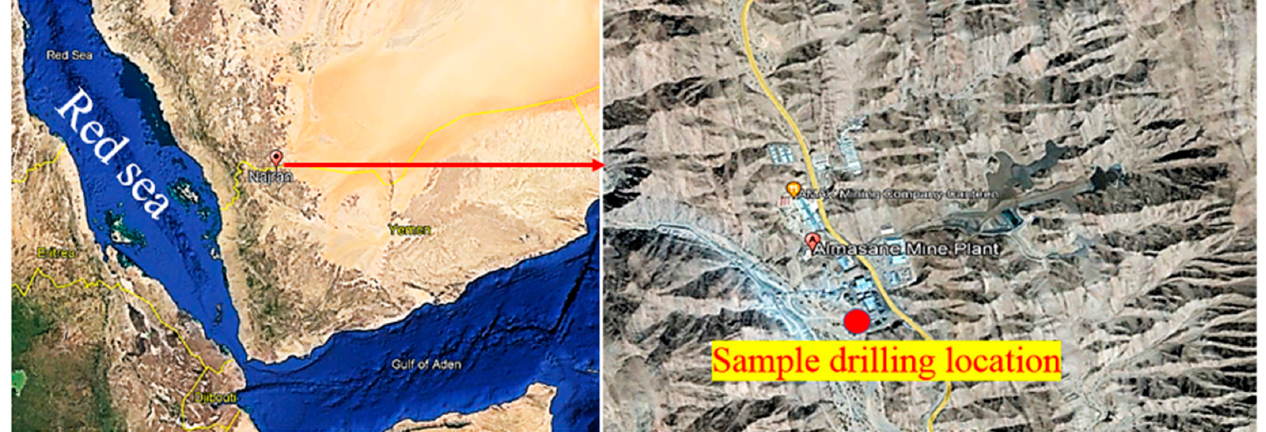
Figure 1. Core drill location, Najran, Saudi Arabia (images were captured using open source Google Earth Pro; 1600 Am- phitheatre Parkway, Mountain View, CA 94043, USA).